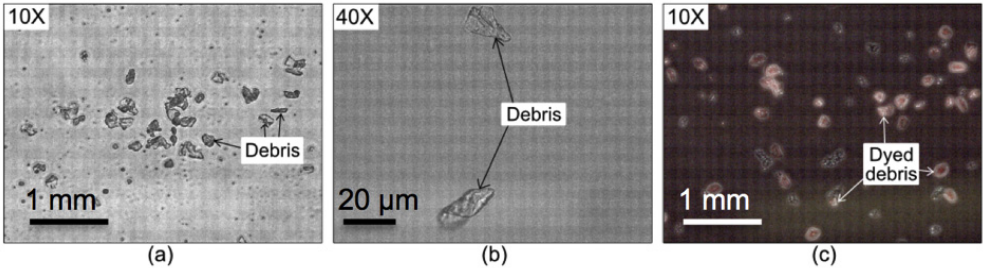
Figure 3. Sample cells from a fingerprint observed under ( a ) 10X and ( b ) 40X lens with an optical microscope in phase-contrast mode; ( c ) stained cell-sample with haematoxylin dye clearly showing the cellular